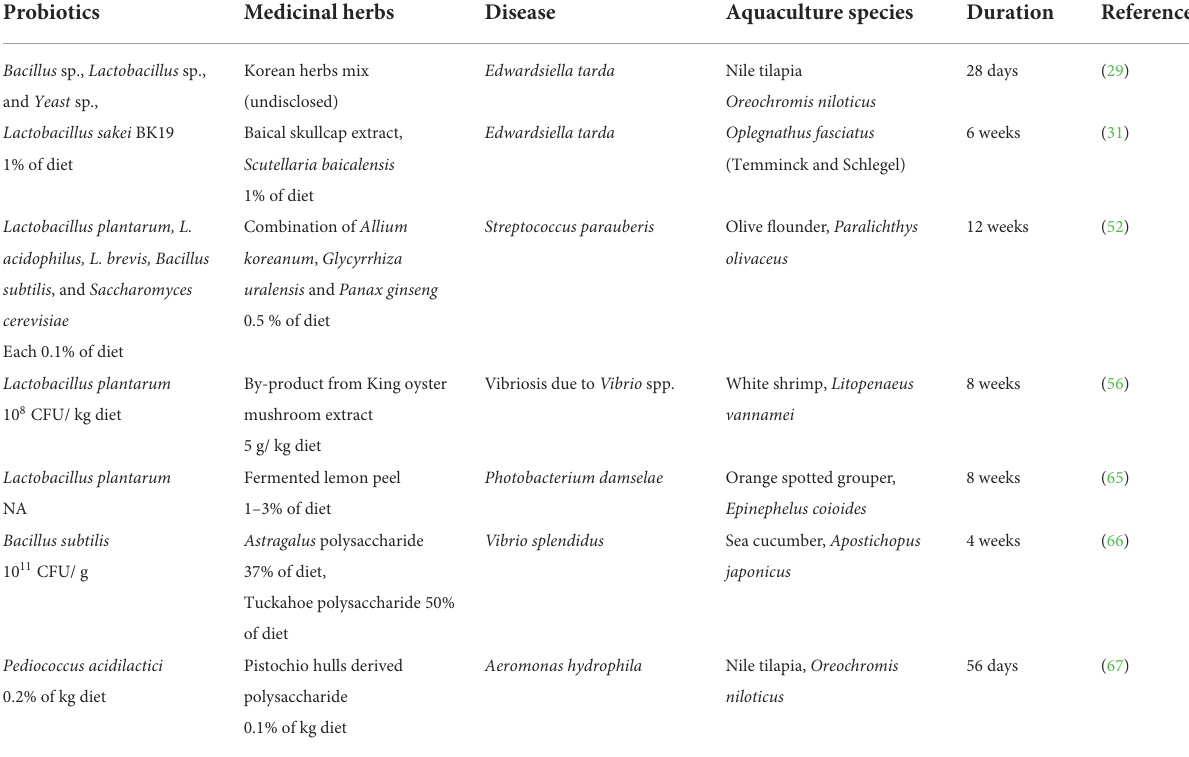
TABLE 4 Application of probiotic and medicinal herb combination in stimulating disease resistance of aquatic animals.